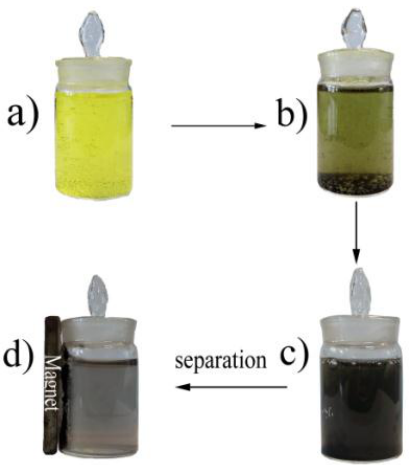
Figure 7. Separation of NiPt-0.6% from solution by a magnet: ( a ) before addition of the catalyst; ( b ) after addition of the catalyst; ( c ) the suspension solution after reaction; ( d ) separation of solid catalysts with a magnet.